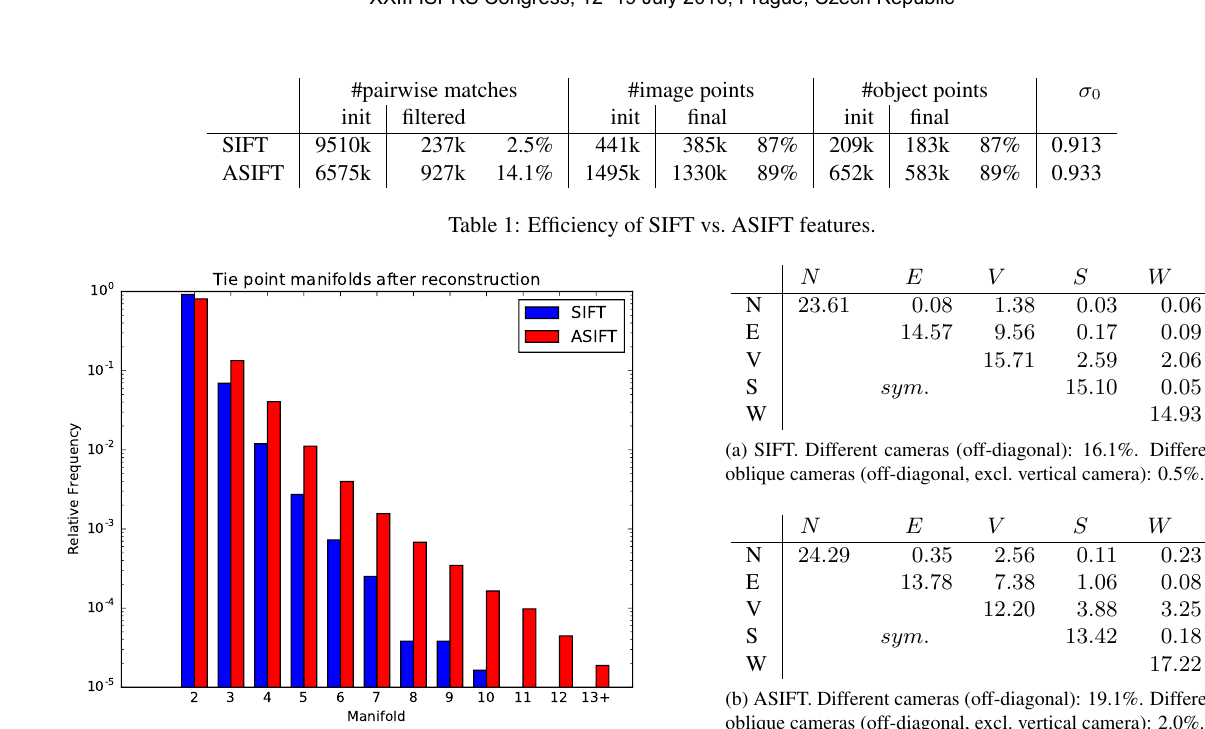
Table 2: Tie points shared by the V ertical and oblique cameras ( N orth, E ast, S outh, W est) after reconstruction [%], for SIFT (a) and ASIFT (b). Note that tie points with multiplicities larger than 2 contribute to more than 1